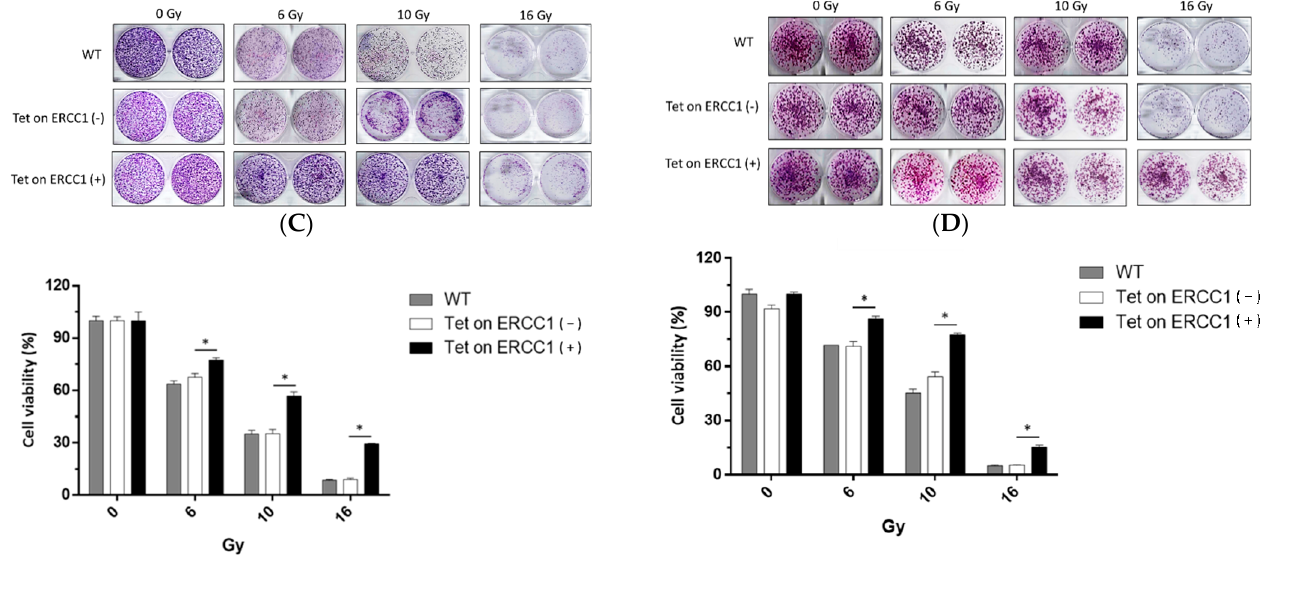
Figure 2. Cell viability was analyzed following ERCC1 overexpression and radiation treatment. Data are shown for ( A ) HCT116 and ( B ) COLO205, including wild type (WT), Tet-onERCC1 cells treated with 2 μ g/mL doxycycline, and untreated cells. All relative luminescence unit (RLU) data were collected following radiation treatment for 24 h. Cell viability percentages were calculated as (abs sample − abs blank )/(abs control − abs blank ) × 100. Colony formation assays of ( C ) HCT116 and ( D ) COLO205, including wild type (WT) and Tet-onERCC1 cells ( E , F ) were statistically significant ( p < 0.05 *).